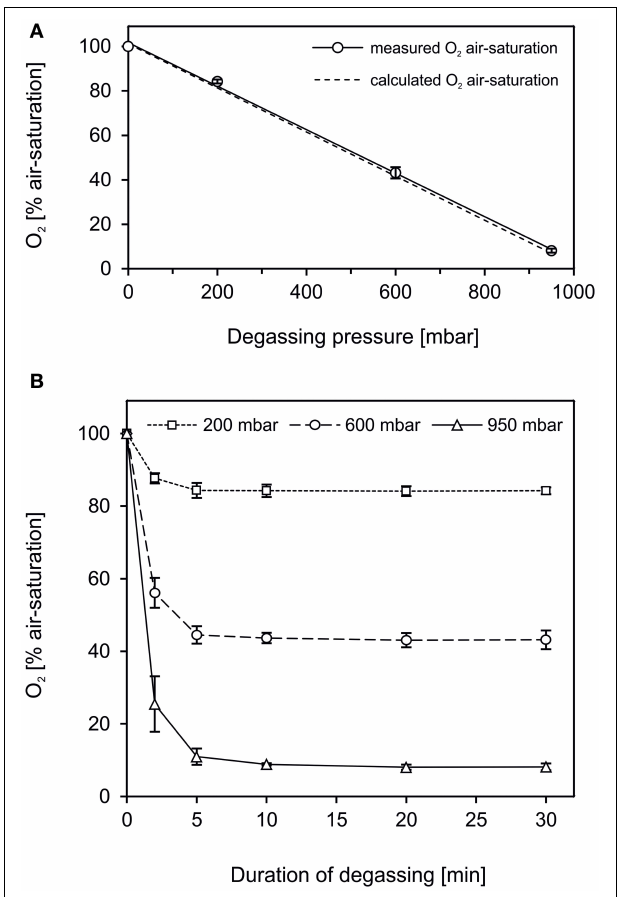
FIGURE 2 | The efficiency of water degassing conducted in a set-up as shown in Figure 1. (A) Deionized water was degassed at 0, 200, 600, and 950 mbar below atmospheric pressure. The level of gas removal, determined as O 2 air-saturation, was positively correlated to the degassing pressure (straight line, R 2 = 0 . 9985 ). The efficiency of the degassing procedure was high and met the theoretical O 2 air-saturation at a given low-pressure calculated according to Henry’s law (dashed line). (B) The gas removal progressed fast, with the major part of gas being removed within the first 2–5min. (A,B) Data are given as mean ± s.d. ( n = 6 ).